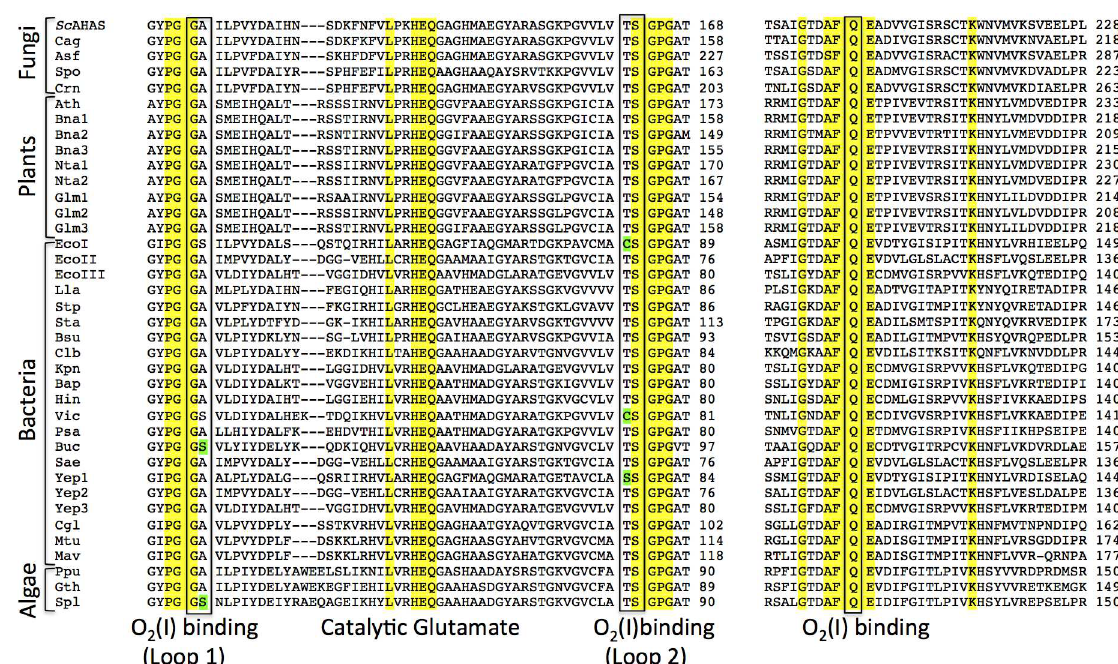
Fig 5. Alignment of AHAS sequences from different organisms highlighting residues in the O 2 (I) binding site. Yellow shadingindicatesresiduesthat are fully conservedin all the enzymes representedhere. Amongst 38 AHAS sequences belongingto all types of organisms producingthis enzyme (bacteria, plants, fungi, algae)P114, G115, and G116 from loop_1 and S163, G164, and P165 from loop_2are fully conserved.Q202, critically important for catalysis, is also fully conserved.A117 and T162 are also highlyconserved,being substituted only in three cases. Notably, T162 can be substituted by a cysteine or a serine residue which can play a similar role in interacting with O 2